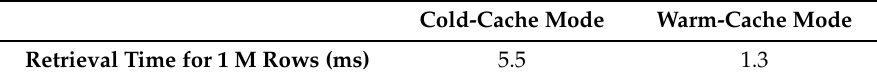
Table 3. Data management